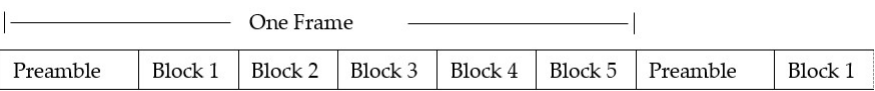
Figure 1. Frame structure of the UA OFDM system.